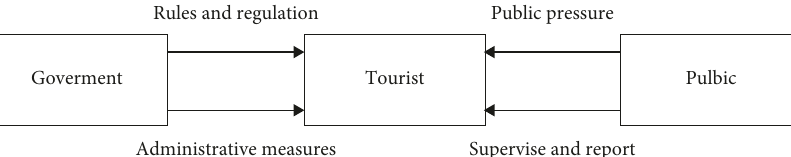
Figure 2: Interaction between the government, the public, and the tourists.